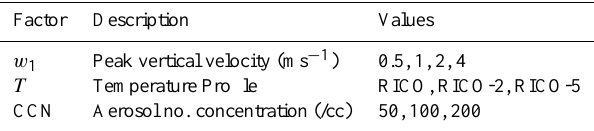
Table 2. Summary of the factorial design for the bin microphysics.